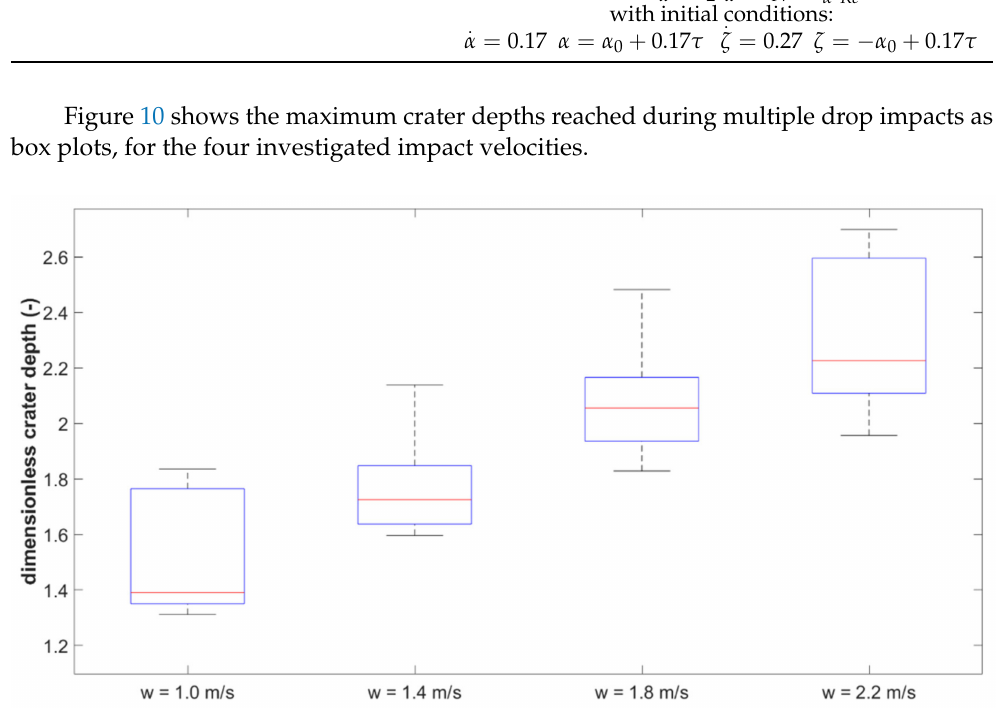
Figure 10. Box plots of the maximum dimensionless crater depth for multiple drop impacts, at the different impact velocities.